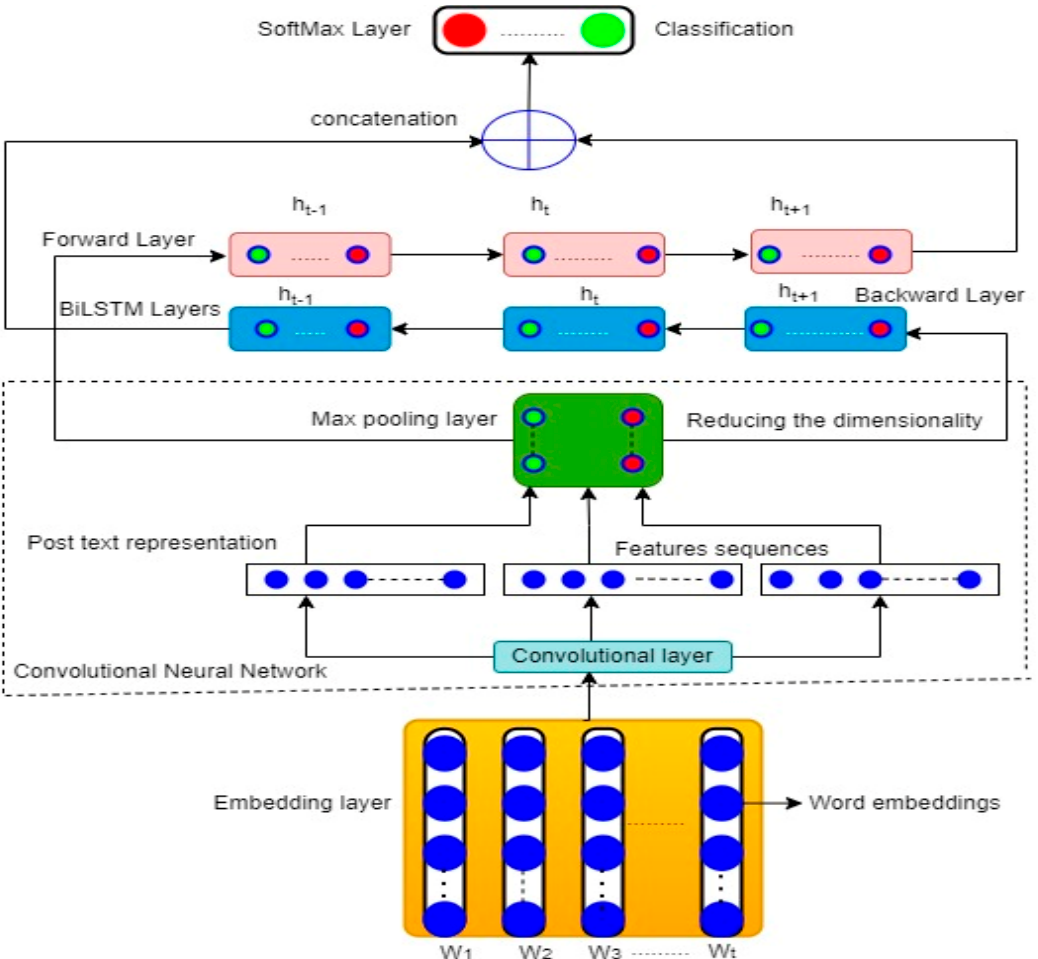
Figure 2. Structure of the CNN–BiLSTM model.